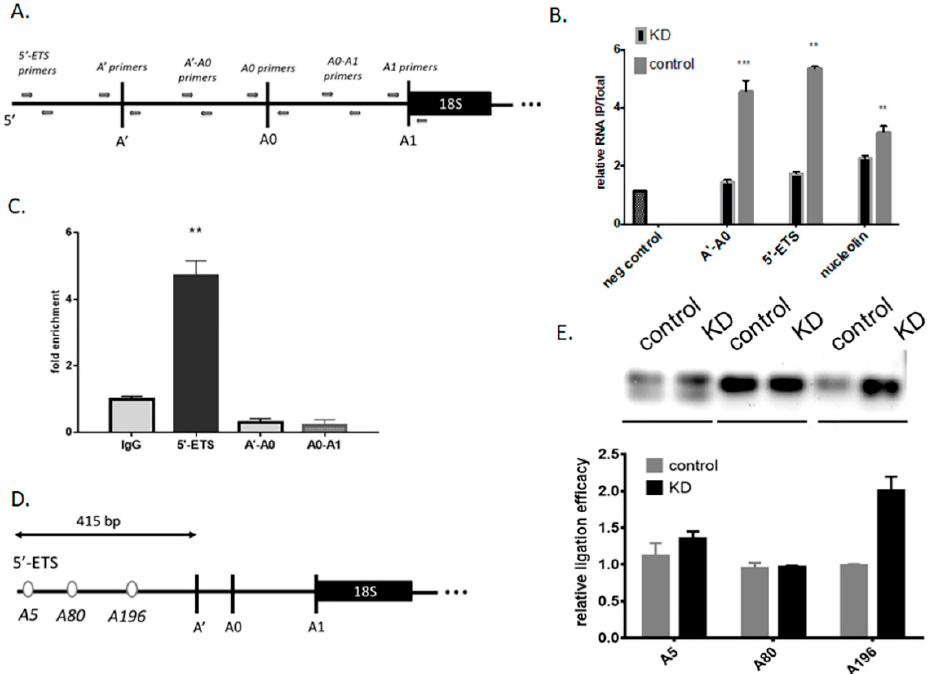
Figure 1. Characterization of RNA methyltransferase Mettl3 interactions with 5 (cid:48) -ETS of 47S pre-rRNA. ( A ) Scheme of the RT-qPCR primer locations on the pre-47S rRNA. ( B ) Relative amounts of rRNA fragments in immunoprecipitates obtained with anti-m6A antibodies from control and Mettl3 KD cells, quantified by RT-qPCR analysis (* p < 0.05, ** p < 0.01, *** p < 0.001). Negative control (unmethylated RNA from the EpiMark ® N6-Methyladenosine Enrichment Kit) A’-A0 (primers for amplification of A’-A0 spacer), 5 (cid:48) -ETS (primers for amplification of the part of 47S pre-rRNA before A’), nucleolin (m6A methylated mRNA based on MeT-DB2.0 browser data). ( C ) Enrichment of rRNA fragments in immunoprecipitates obtained with anti-Mettl3 antibodies from control cells, quantified by RT-qPCR analysis. ( D ) Scheme of 5 (cid:48) -ETS in rRNA with designated adenosines in the context of predicted DRACH sequences. ( E ) PCR analysis of T4 RNA ligase assay for pre-rRNA from control and Mettl3 KD cells (visualization of fragments separated using gel-electrophoresis and their relative quantification).